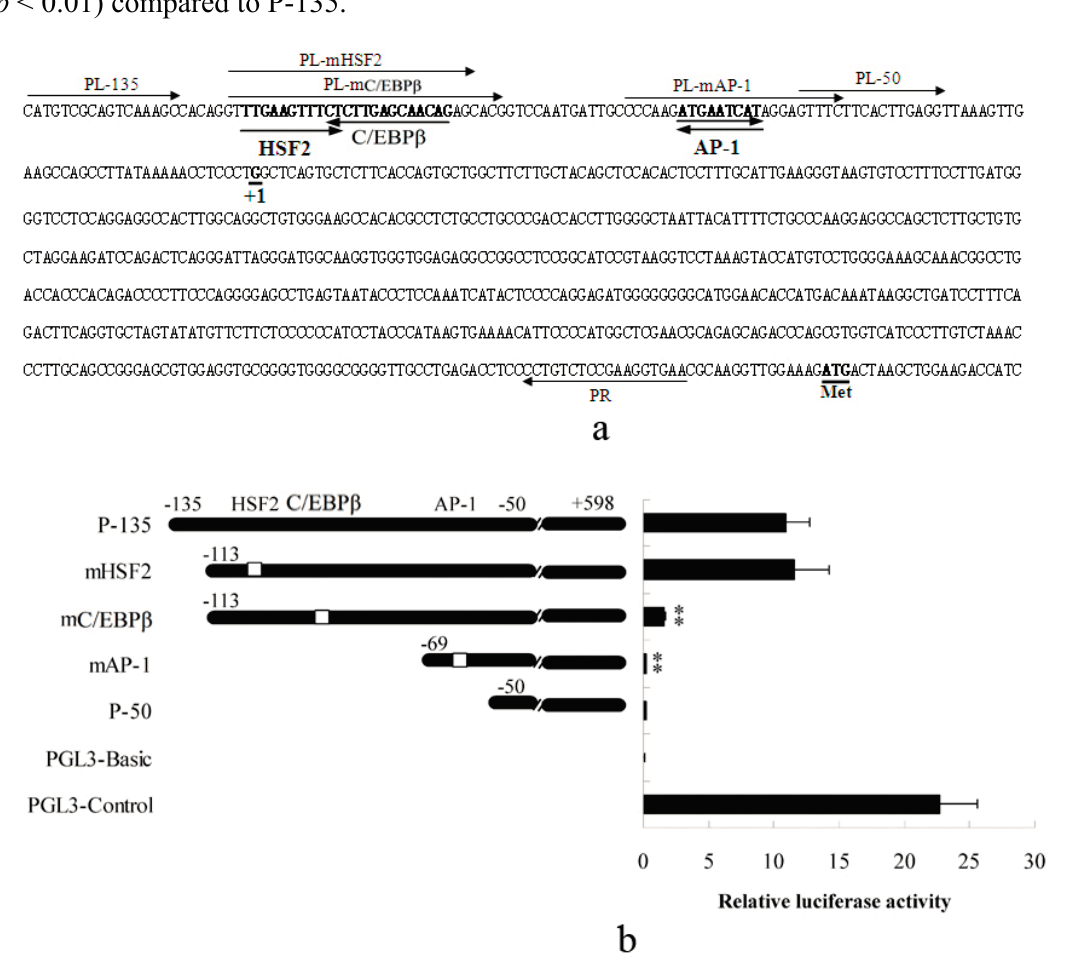
Figure 1. Transcriptional activity of the porcine S100A12 gene promoter. ( a ) Binding sites of the transcription factors HSF2, C/EBP β , and AP-1 are shown in bold and the orientation of these transcription factors are indicated by bold arrows. The primers for promoter fragment isolation and binding site mutation are also indicated by arrows. +1 indicates the transcription start site; ATG, the initiating codon of the coding region; ( b ) The transcriptional activity of the porcine S100A12 gene promoter was significantly decreased when C/EBP β binding site was mutated and almost abolished when both C/EBP β and AP-1 binding sites were deleted. P-135 contains regions − 135 to +598 of the promoter; mHSF2 contains regions − 113 to +598 with a mutated HSF2 binding site; mC/EBP β contains regions − 113 to +598 with a mutated C/EBP β binding site; mAP-1 contains regions − 69 to +598 with a mutated AP-1 binding site and P-50 contains regions − 50 to +598. All fragments were cloned into a pGL3 vector, and the pGL3-Basic and pGL3-Control were used as negative and positive controls, respectively. Error bars represent mean ± SEM, representative of at least three experiments. mAP-1, C/EBP β Vs P-135; ** indicates significant differences ( p < 0.01) compared to